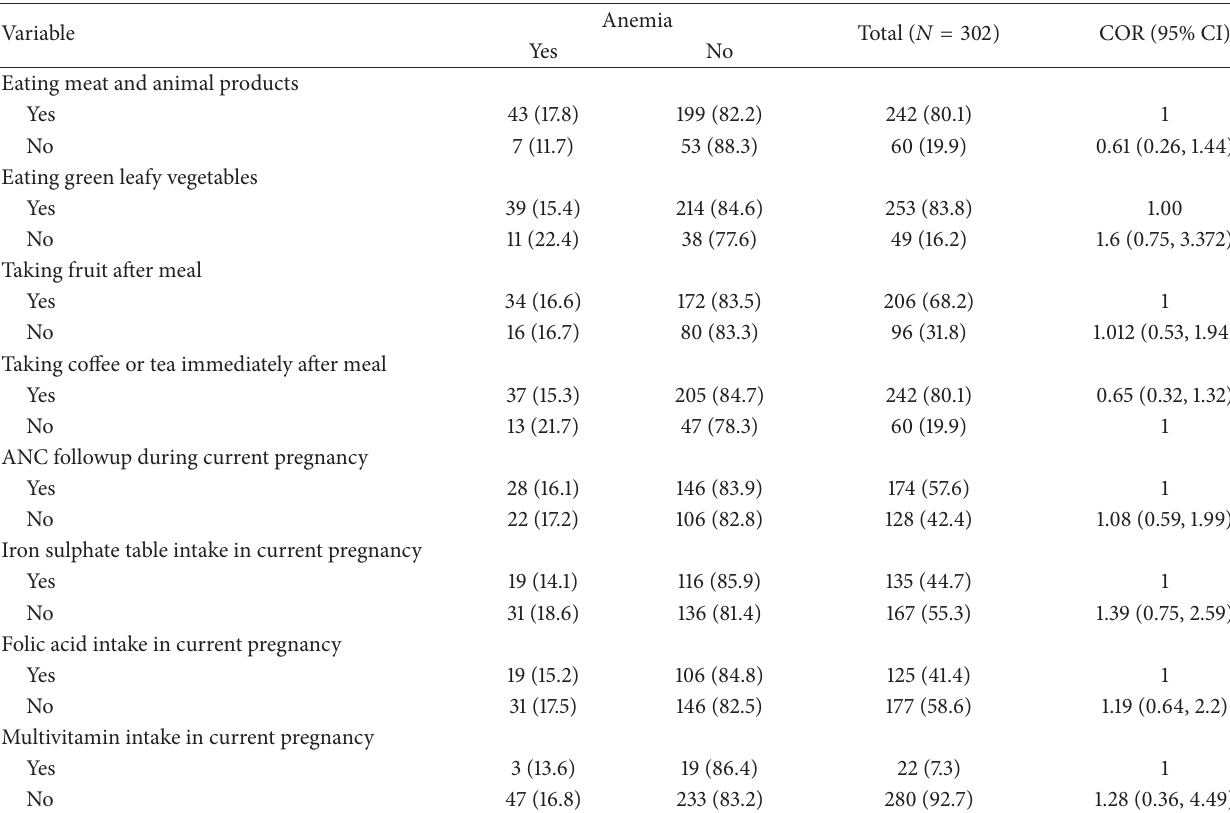
Table 3: Prevalence of anemia in relation to dietary habit, ANC followup, and nutrient supplementation at their current pregnancy period ( 𝑛 = 302 ).